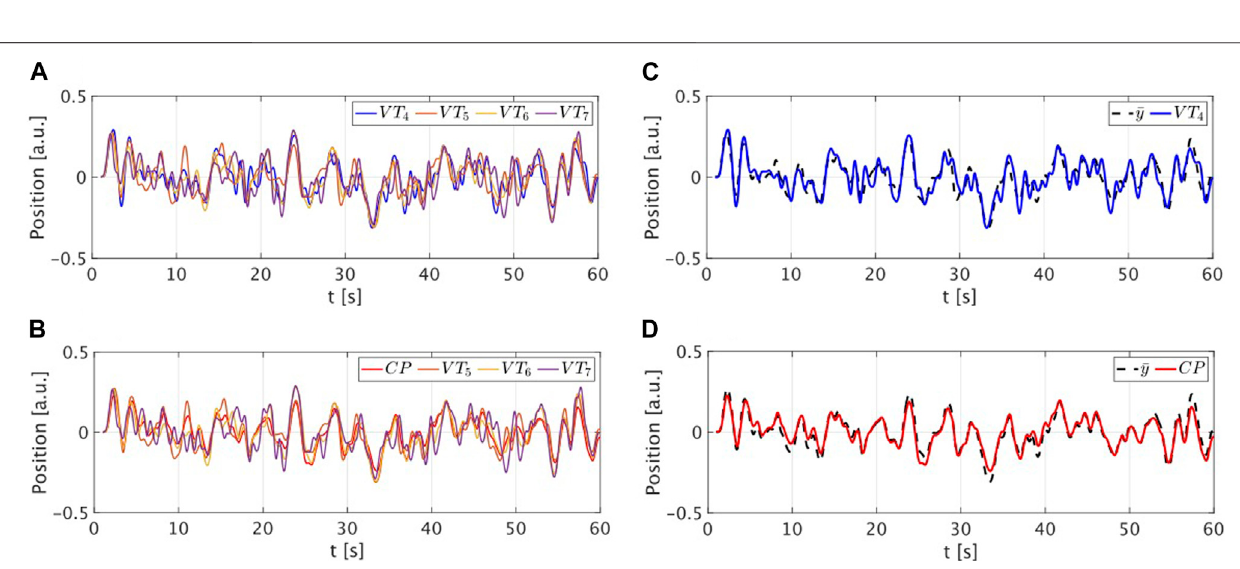
FIGURE3| Sampletrialofagroupsession. (A,B) PositiontimeseriesofthetargetVT 4 andoftheCPwhileplayingwiththeothervirtualtrainers.Differentcoloursareusedfor different players. (C,D) Position time series of the target VT 4 (in blue) and of the CP (in red) reported together with the mean position of the neighbours (in dashed black).